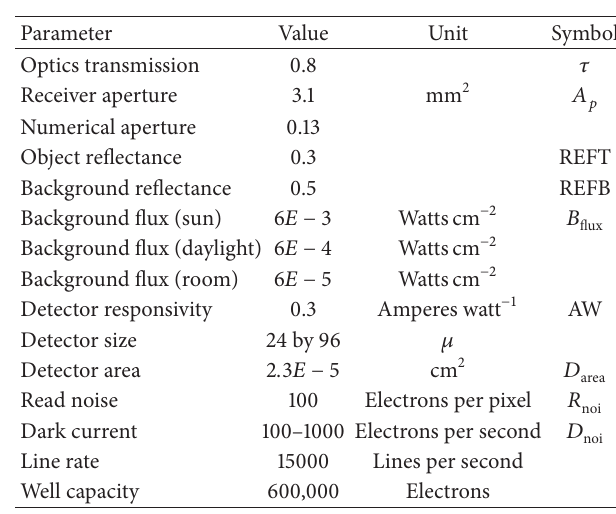
Table 2: Parameters used in range calculations. Irradiance values are in watts per square centimeter (watts/cm 2 ).